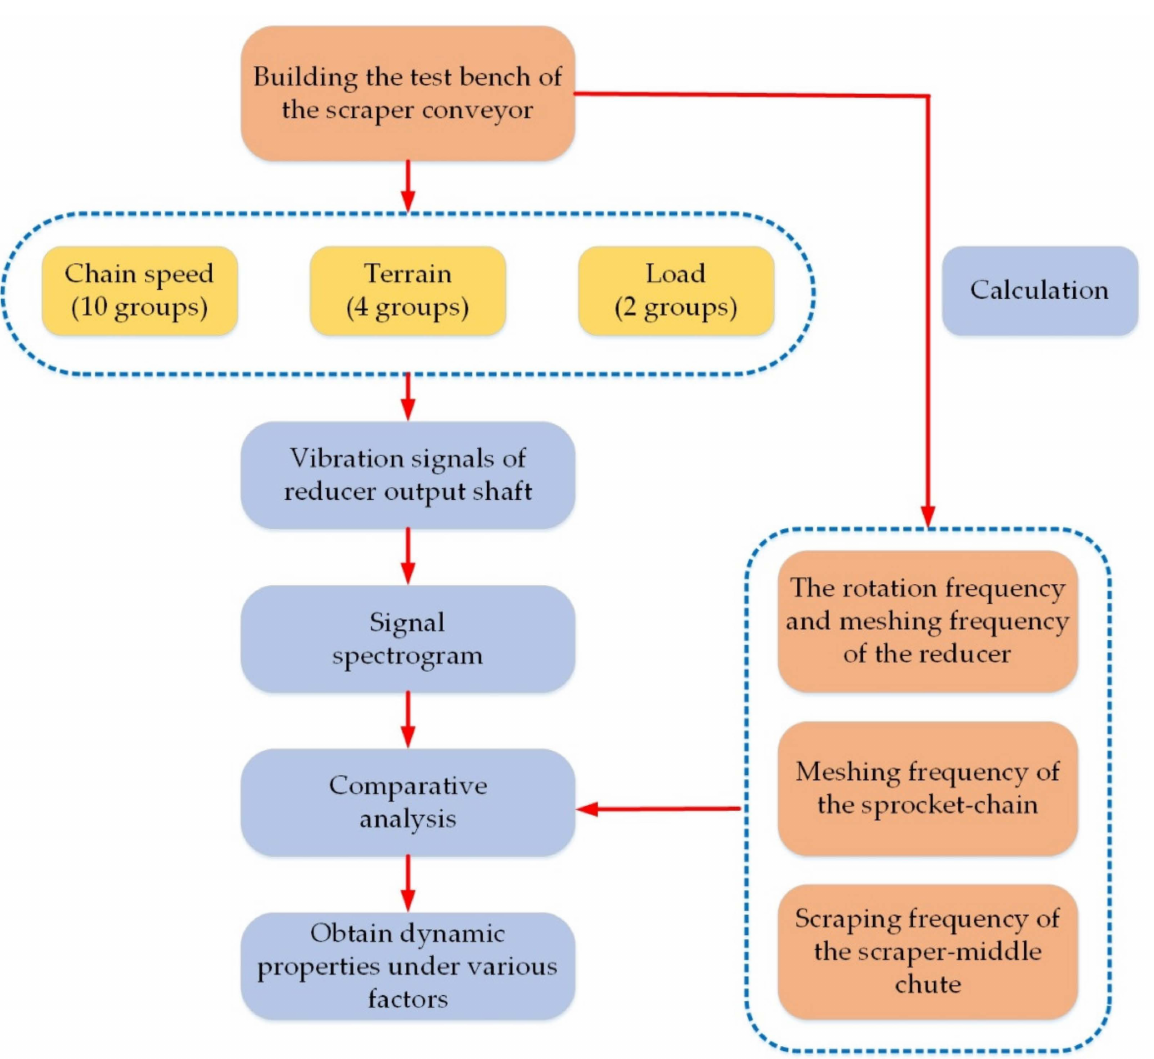
Figure 1. Test bench of dynamic properties for the scraper conveyor.